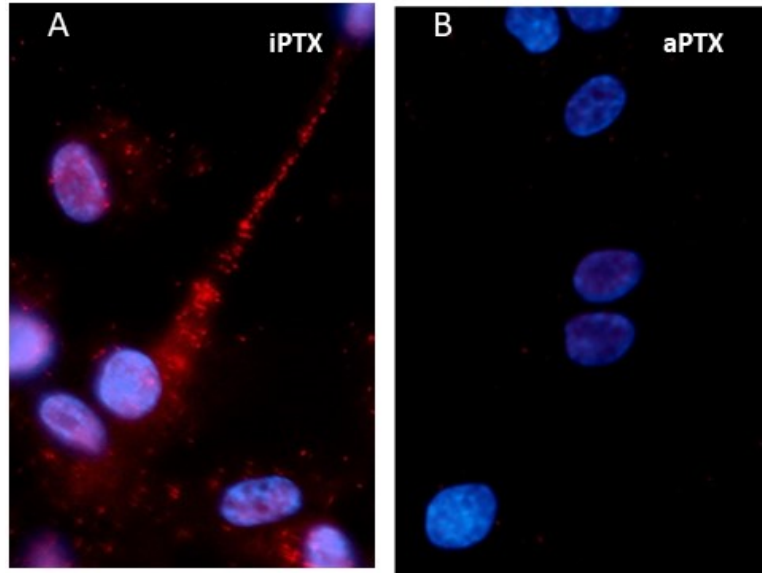
Figure 1. In situ proximity ligation analysis (PLA) of the interactions of mPR α with an inhibitory G protein (G i ) using specific mPR α and G i α -subunit antibodies in human vascular smooth muscle cells (VSMCs). ( A ) A close association (distance < 40 nm) between mPR α and G i is shown by the presence of red dots in the image, which had been preincubated with inactivated pertussis toxin (iPTX). ( B ) The PLA image shows a marked decrease in the number of red dots in VSMCs that had been pretreated with activated pertussis toxin (aPTX). Treatment with aPTX uncouples G i from hormone receptors, whereas iPTX is inactive. Nuclei are stained blue with DAPI. Reproduced from Pang and Thomas [48] with permission.